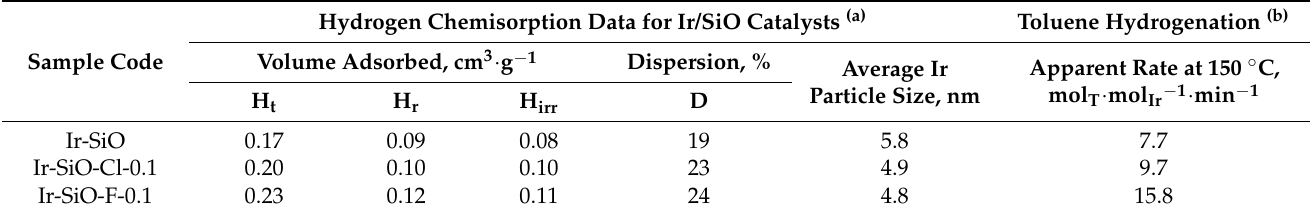
Table 3. H 2 -chemisorption data and activity of indicated catalysts.